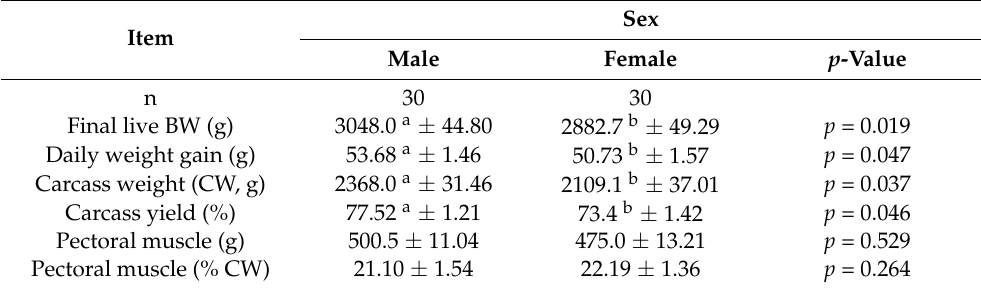
Table 2. Effects of sex on growth and slaughter performance of chickens reared in the organic system at 82 days (mean values ±